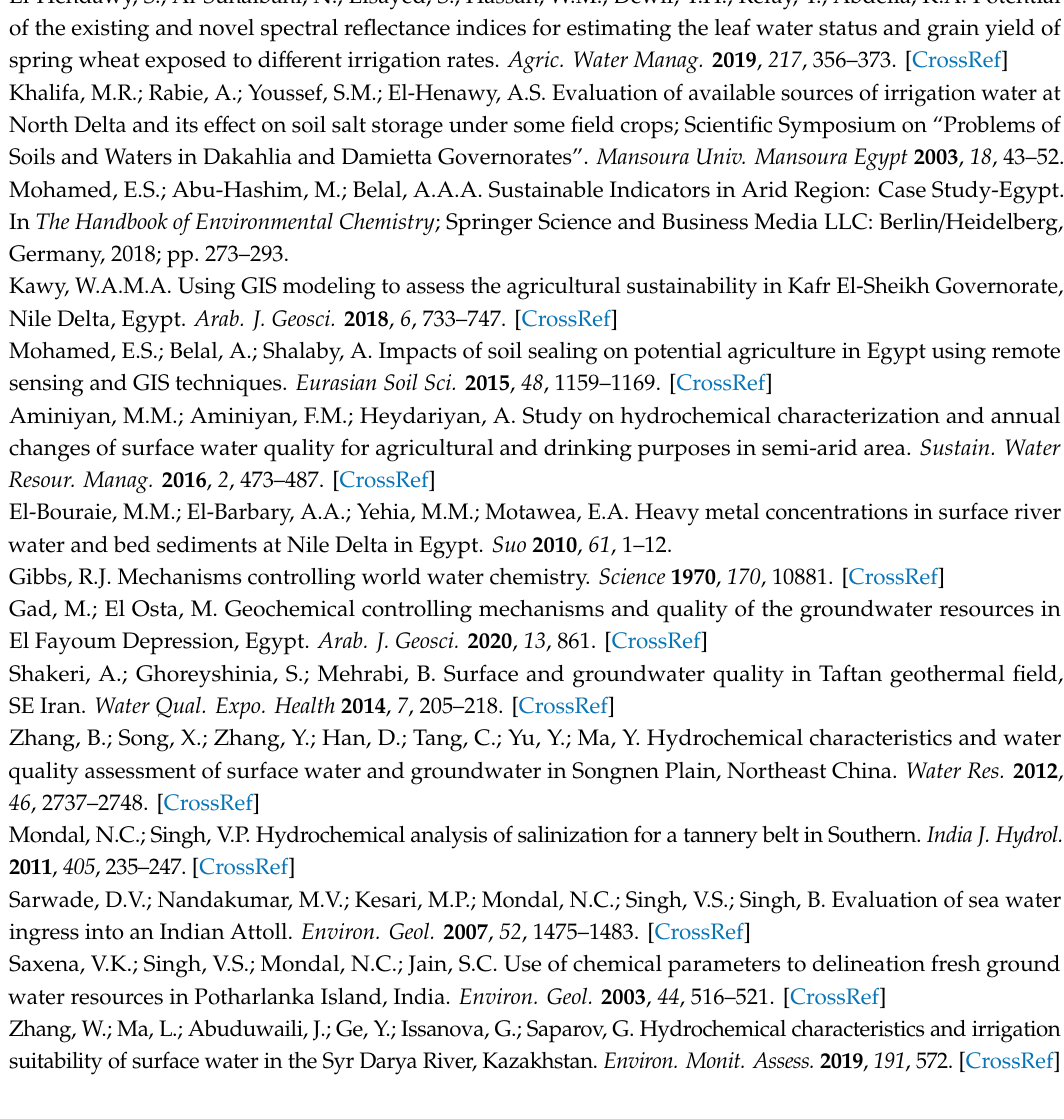
Table S1. Analytical results of the measured physicochemical parameters in the collected surface water samples during summer 2018. Table S2. Analytical results of the measured physicochemical parameters in the collected surface water samples during summer 2019. Table S3. Infiltration and permeability hazard group classification according to rate [36]. Table S4. Classification of trace element toxicity